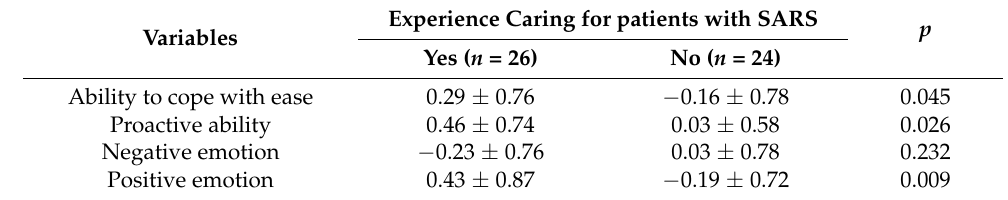
Table 5. Comparison of the self-efficacy and emotional traits of subjects with or without the experi- ence of SARS care in their actual care for COVID-19